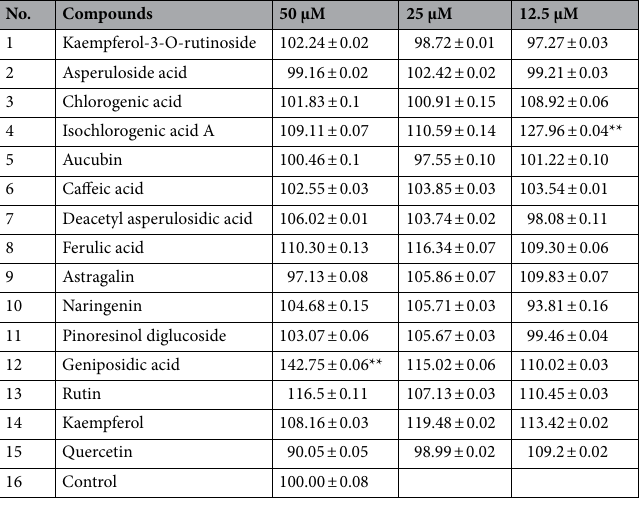
Table 2. Effects of main compounds in EUF on the survival rate of cell Leydig viability (%). *P < 0.05, **P < 0.01 versus the control